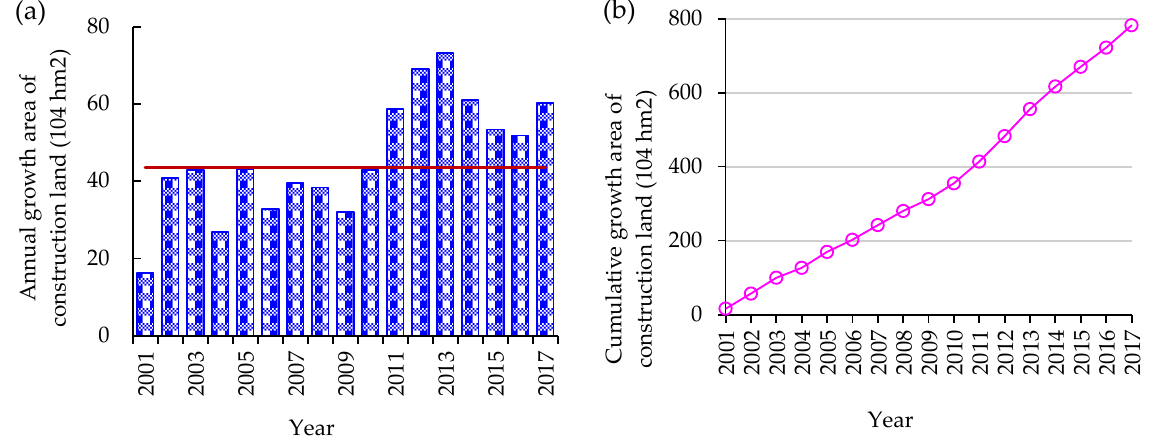
Figure 1. Annual growth area and cumulative growth area of construction land during 2001–2017. ( a ) Annual growth area, and ( b ) cumulative growth area.